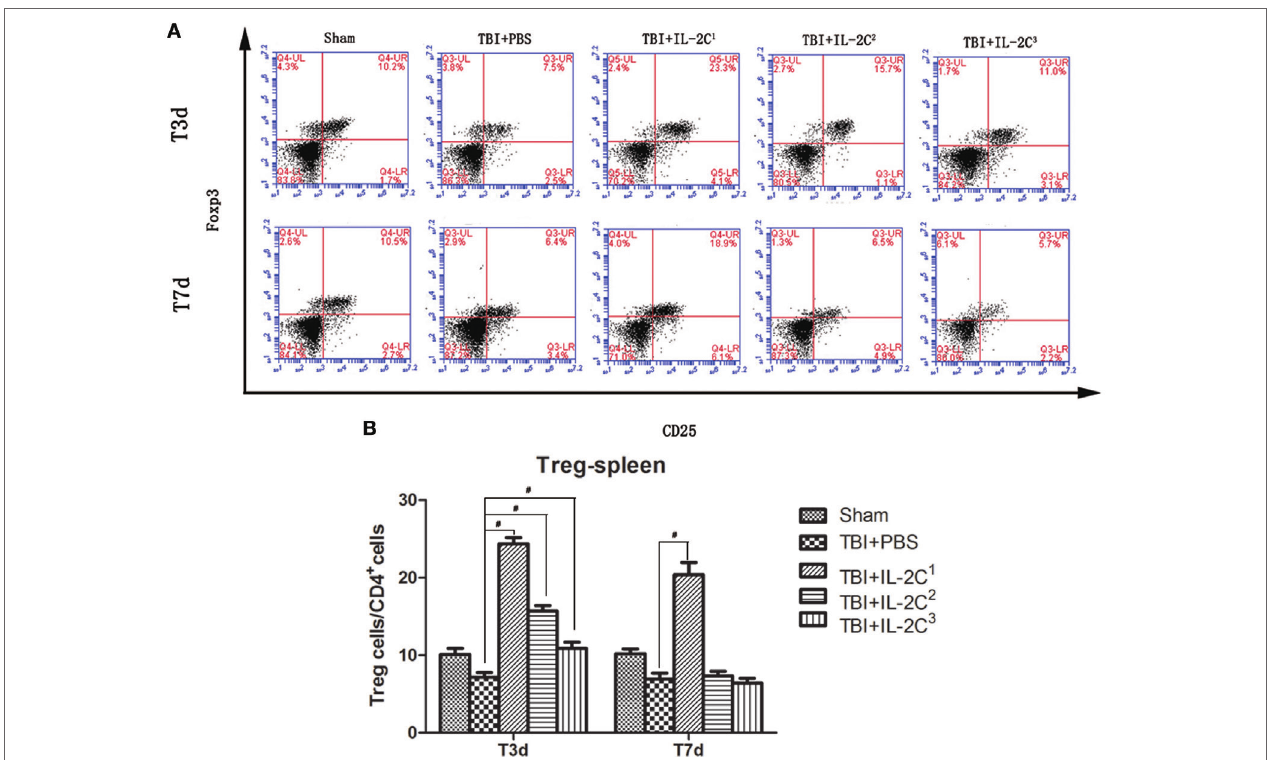
FigUre 3 | (a) IL-2C administration dose-dependently increased the number of CD4 + CD25 + Foxp3 + T cells in the spleen. Plots represent the percentage of CD25 + Foxp3 + cells within the CD4 + population. (B) Cell count analysis indicated that three consecutive injections of the IL-2C increased the number of Tregs after 3 and 7 days. Data are presented as the mean ± SD; * p < 0.05 and # p < 0.01 ( n = 5 mice/group).